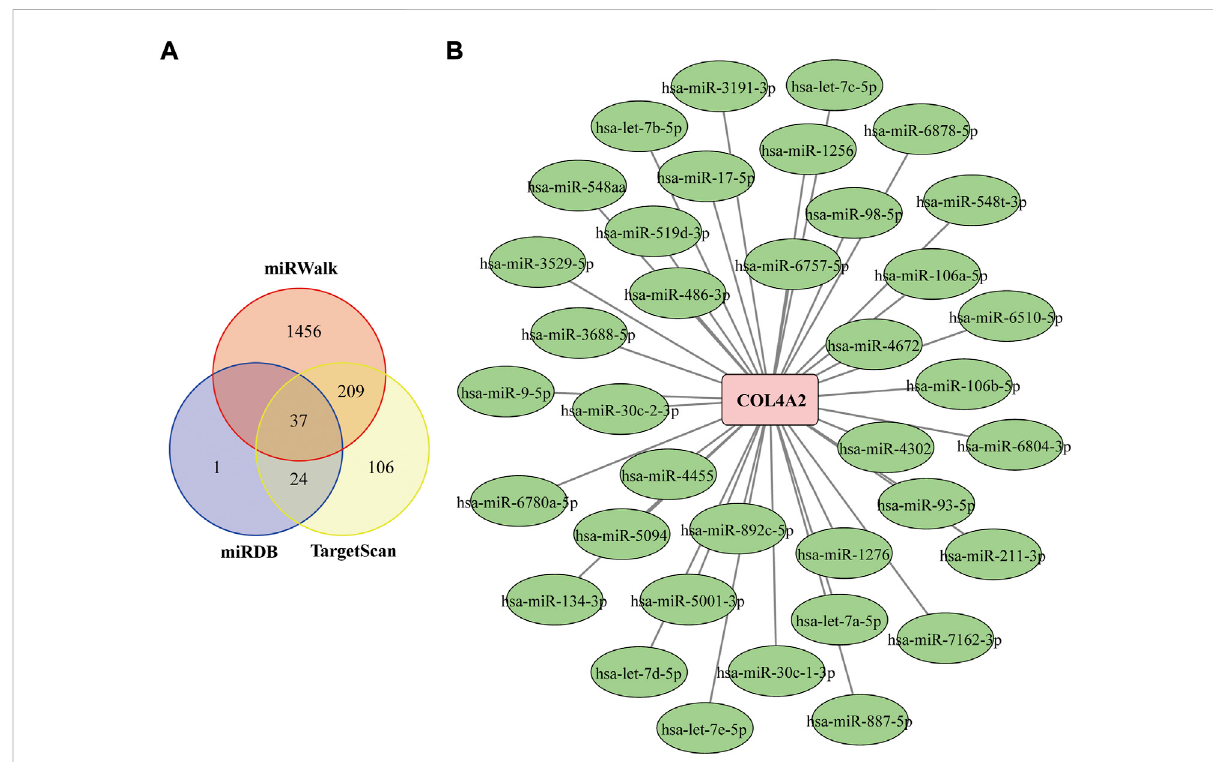
FIGURE 8 Construction of the COL4A2 – miRNA Regulatory Network (A) Venn diagram of the intersection of targeted miRNAs screened by miRWalk, miRDBandTargetScandatabases. (B) COL4A2 – miRNAregulatorynetwork.Thesquarerepresentsgene,andthecirclerepresentsmiRNA.Thegreen frame represents down-regulated miRNA, and pink frame means up-regulated